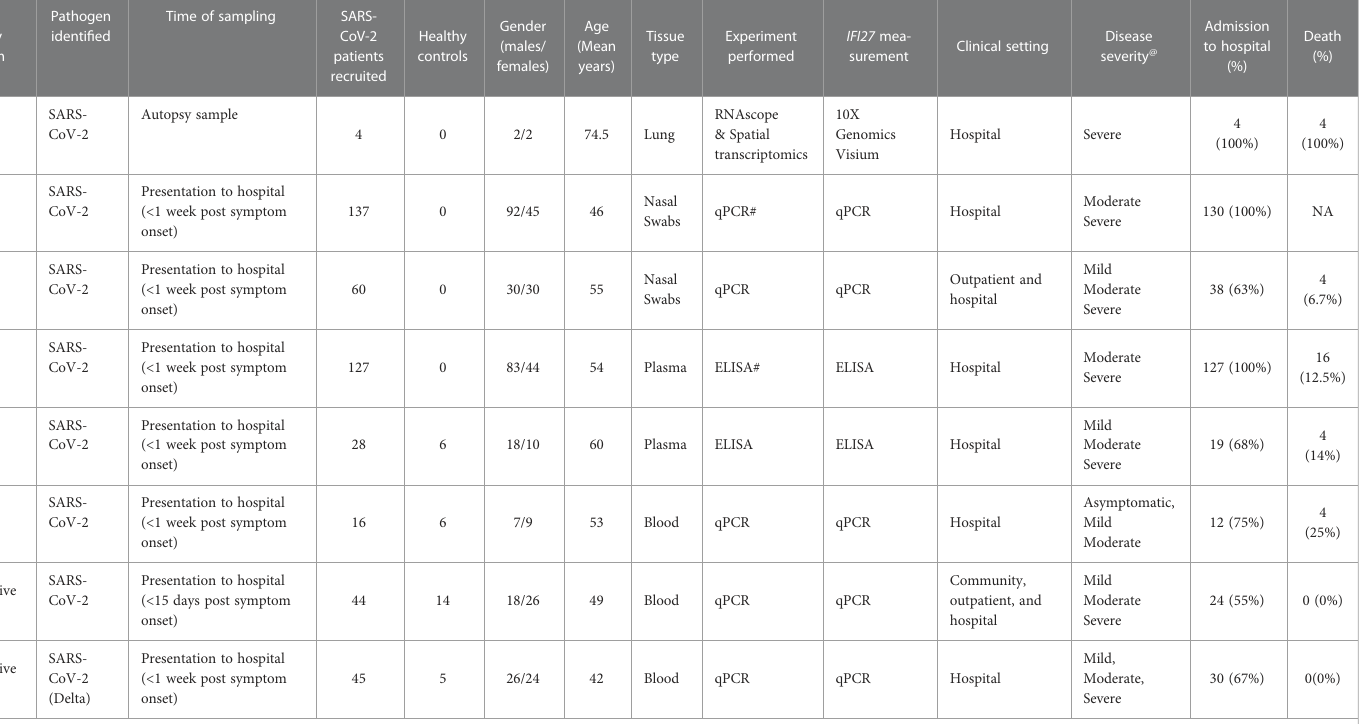
TABLE 1 Overview of cohorts included in the